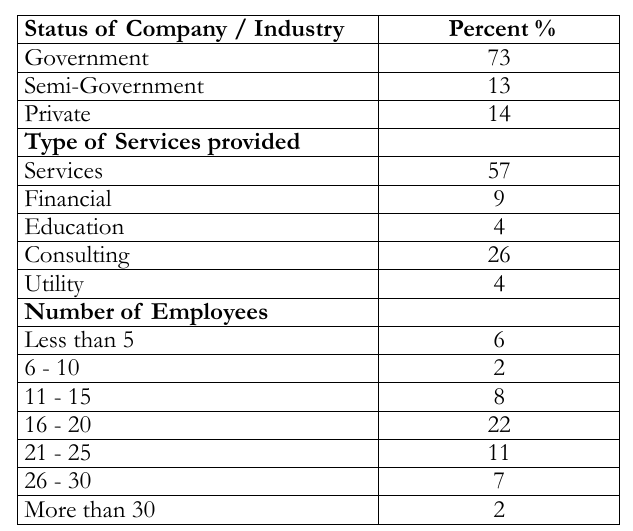
Table 2. The demographic profile of the company/